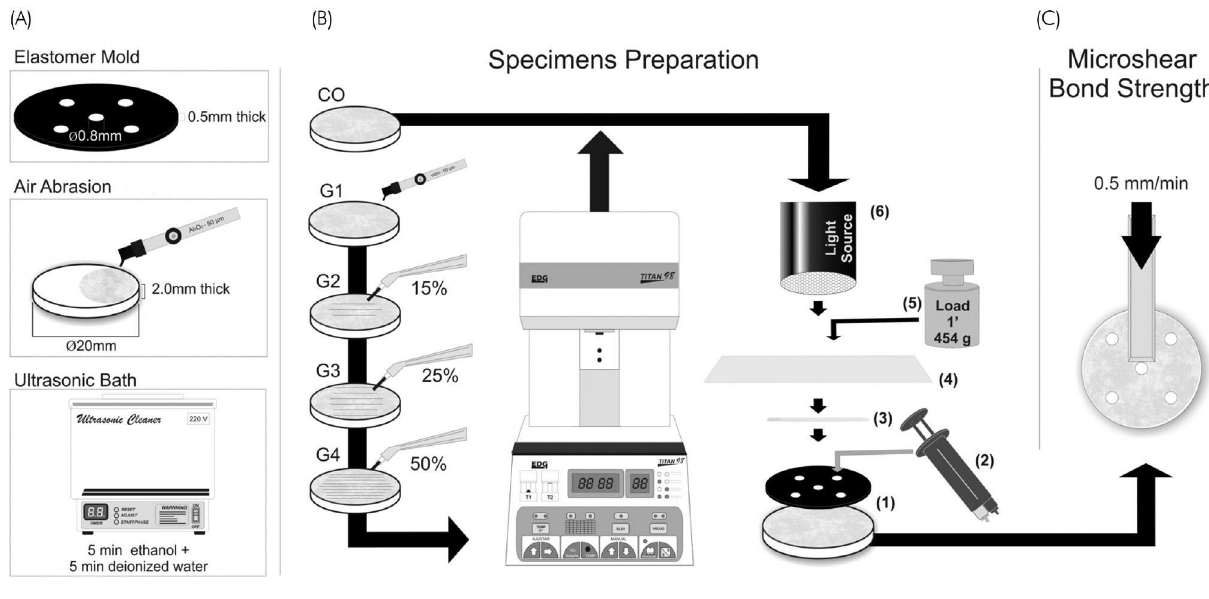
Figure 1. Image A shows the elastomeric mold, abrasion with Al O particles and ultrasonic bath prior to adhesive procedures. 2 3 Image B shows the treatments applied to each group, the CO (non-treated) and glass applications, according to each group, as well as the firing (G1-G4). Observe the following adhesion procedures: (1) an elastomer mold positioned onto the zirconia disc surface after silane coating, in the groups treated with glass; (2) orifices filled with resin cement; (3) polyester strip and (4) glass slab over the filled mold; (5) cementation load applied for 1 min (454 gF); (6) photo-activation of resin cement (20 s in each orifice). Image C represents the μsbs